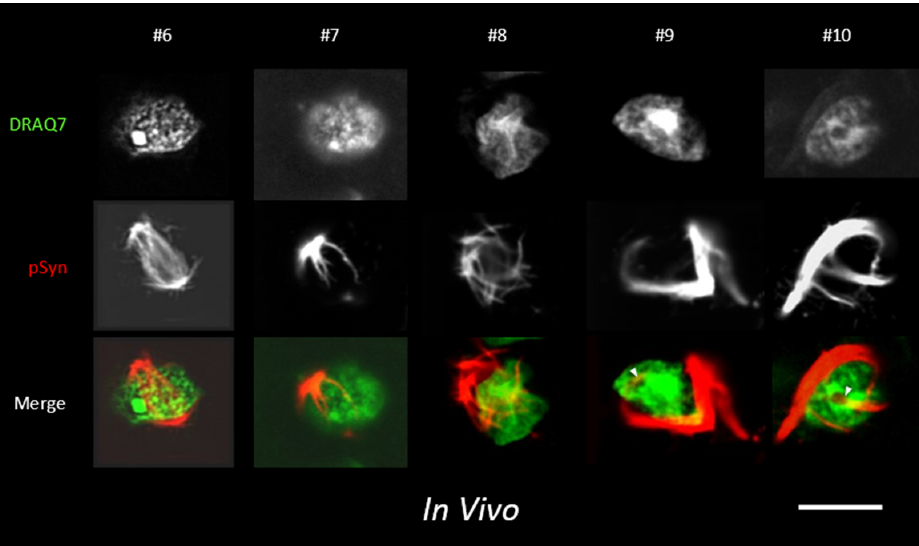
Figure 11. LSCM optical sections of the α -Syn pathology spread in a mouse injected 4 months before with 1B fibrils. Phospho-S129 α -Syn: coded in red; DNA/DRAQ7: coded in green. Zone injected with 1B and sampled by LSCM: right substantia nigra. Five individual nigral neurons (#6 to #10) bearing NCIs and NIIs are shown. For description see text. Scale bar: 10 μ m.